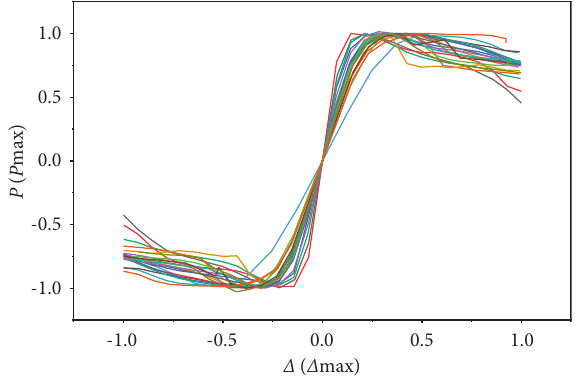
Figure 9: Skeleton curves of 22 STHCC specimens.